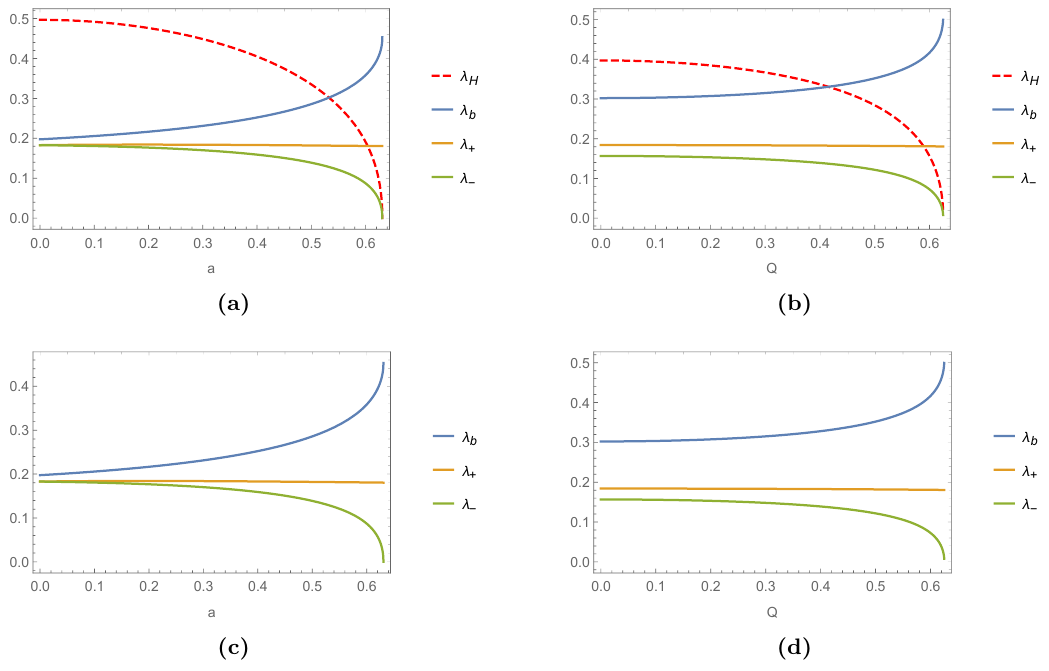
Figure 6. (a,b) Comparison between the Lyapunov exponents of a BH with M = 1, ‘ = 3 and its temperature as a function of the rotation parameter a (left, Q = 0 : 7) and the BH charge Q (right a = 0 : 7). (c,d) The BH temperature has been removed to highlight the hierarchy between (cid:21) b , (cid:21) + and (cid:21) (cid:0)